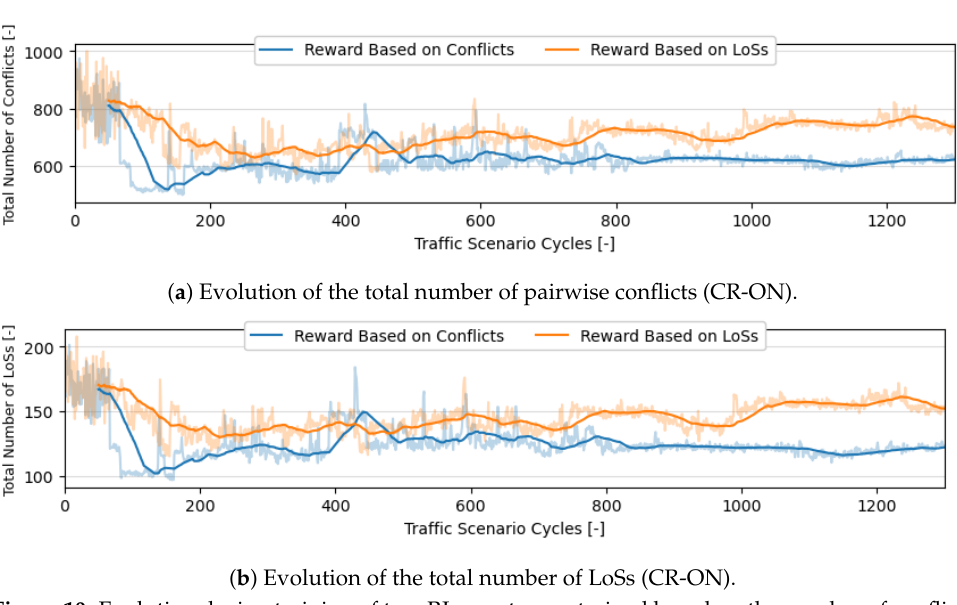
Figure 10. Evolution during training of two RL agents, one trained based on the number of conflicts (in blue) and the other on the number of LoSs (in orange). Conflict resolution was applied in this